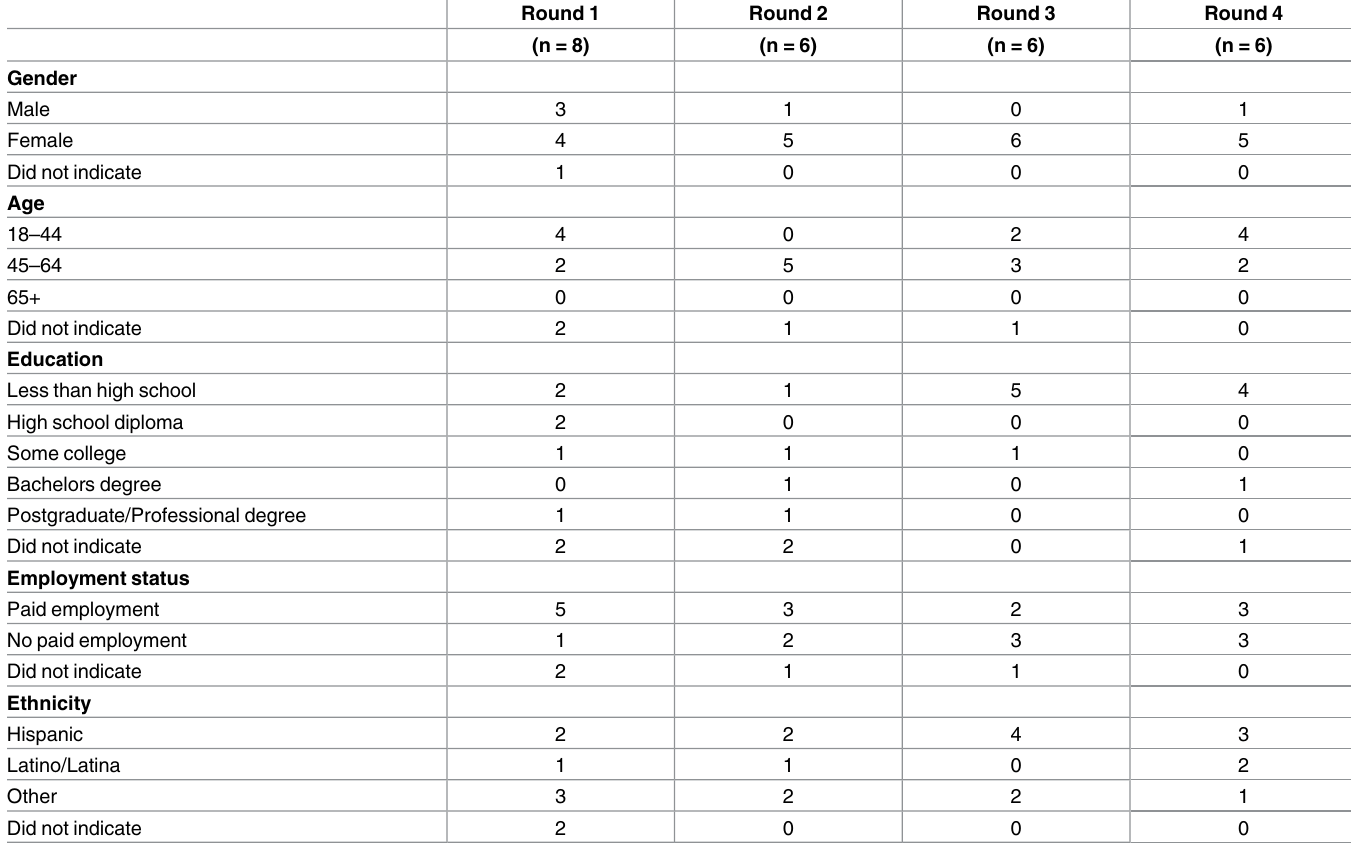
Table 2. Participant